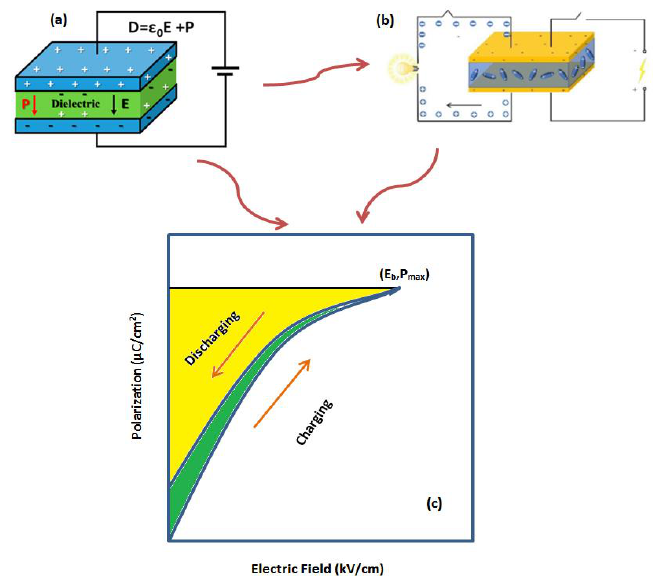
Figure 2. ( a ) Charging; ( b ) Discharging; and ( c ) Schematic diagram for calculating the unipolar P–E loop efficiency of dielectric capacitors as a foundation for assessing energy-storage effectiveness